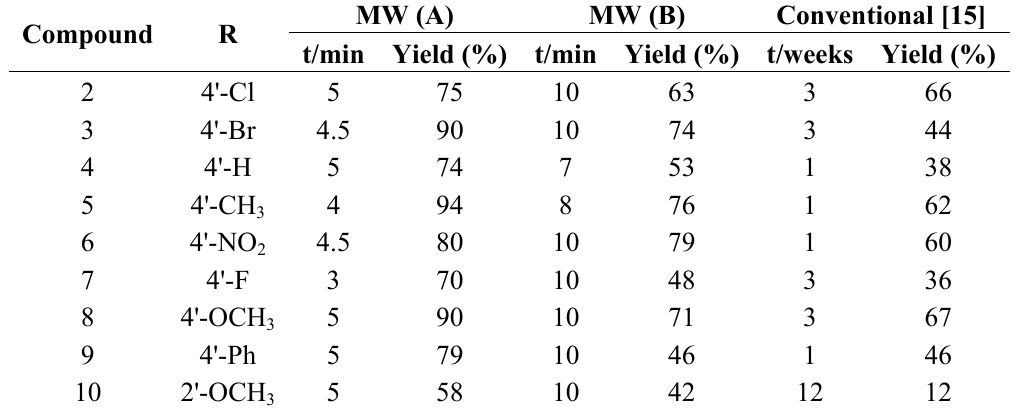
Table 1. The optimized conditions in the synthesis of quaternary salts under MW heating in acetone A and solvent-free procedure B as well as under classical